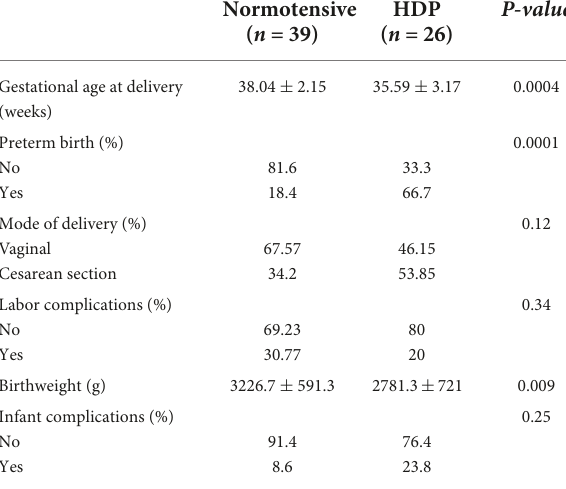
TABLE 2 Birth outcomes between women with normotensive pregnancies and hypertensive disorders of pregnancy